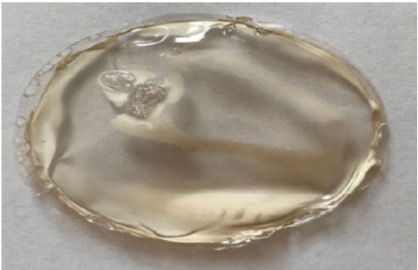
Figure 2. Photograph of a dried foil prepared from the HPMC mixed with glucose as a reducing agent. White opaque streaks of crystallized glucose are clearly visible in the otherwise transparent HPMC